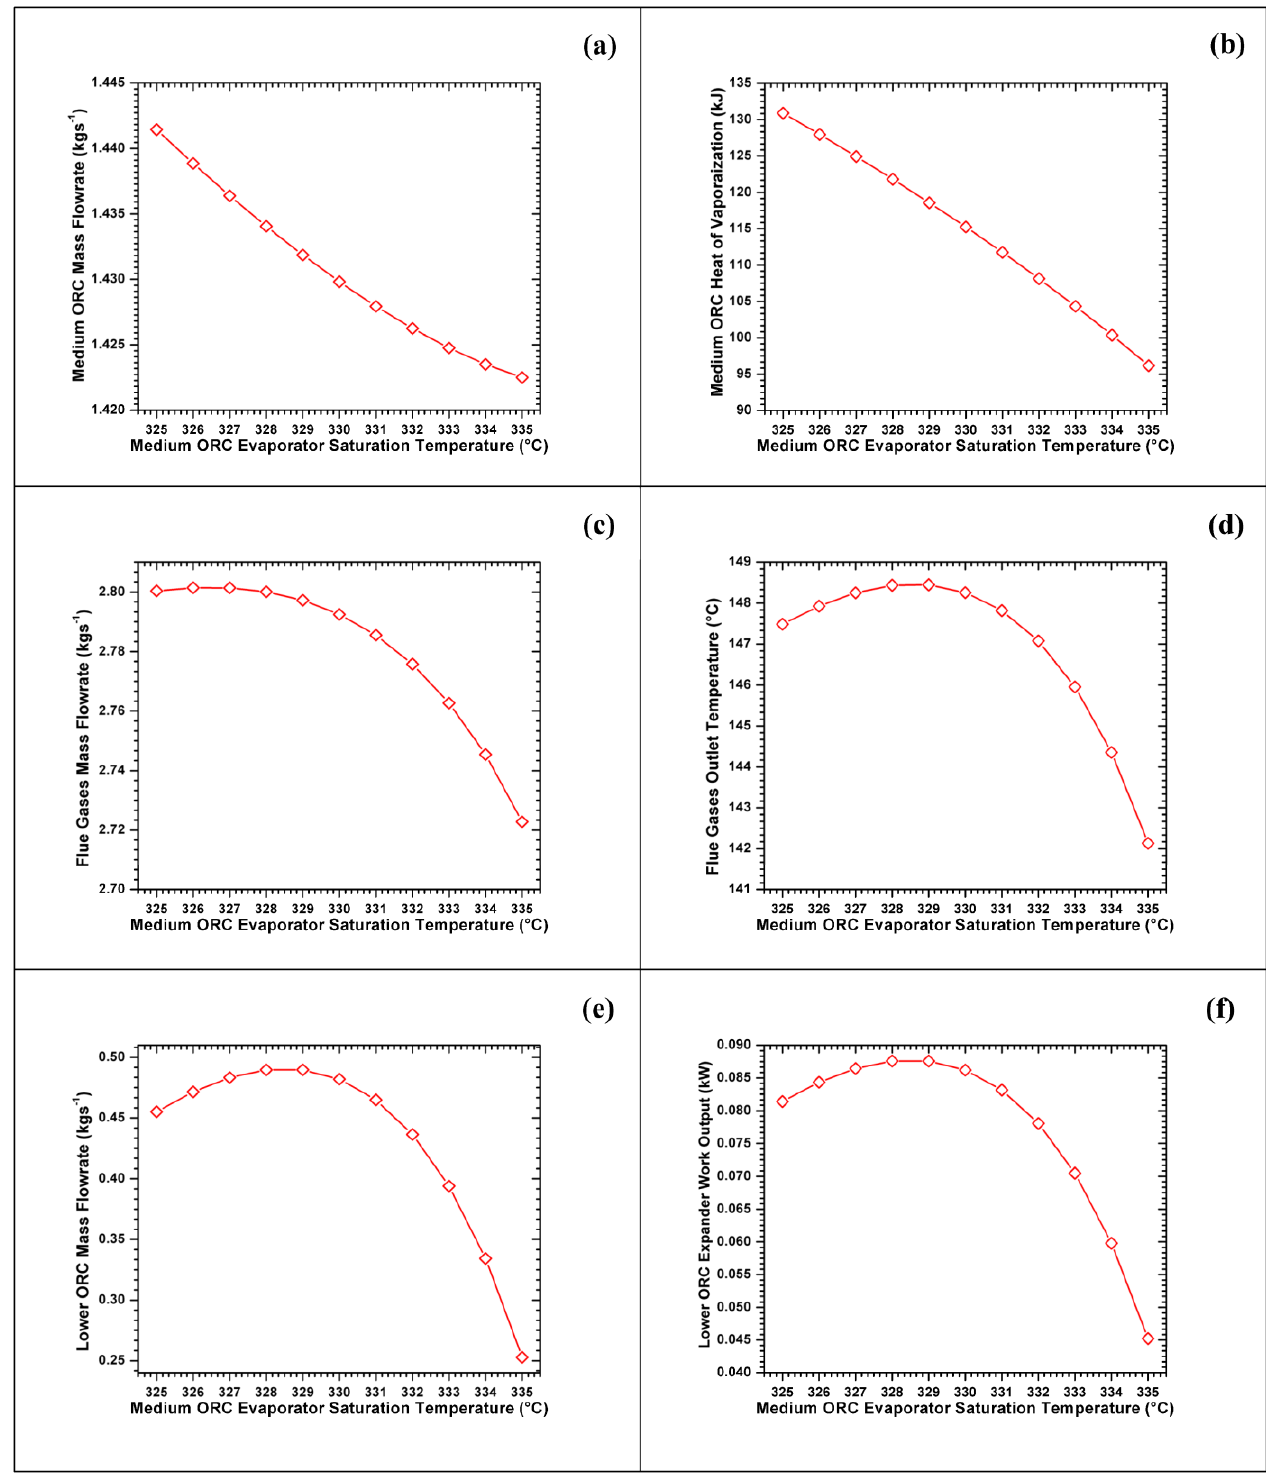
Figure 7. The variation of ( a ) medium ORC mass flowrate, ( b ) medium ORC heat of vaporization, ( c ) flue gases mass flowrate, ( d ) flue gases outlet temperature, ( e ) low ORC mass flowrate, ( f ) low ORC expander work output against the medium ORC evaporator saturation temperature.